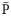
Average positive and negative power about the arms (P¯arm) and legs and trunk (P¯T+L) for the poling (A-D) and swing (E-H) phases in uphill double-poling at increasing external power at shallow (INC5, 5%) and steep (INC12, 12%) inclines. Values are means and 95% CI [N = 14]. # indicates test for interaction; if sig. interaction, p-values are shown for simple main effect for each incline (5% and 12%) while if non-sig. interaction, p-values are shown for main effect of incline (Inc.) and WR (work rate); a,b, and c indicates sig. difference from low, mod, and high work rates at each incline, respectively (p<0.05), if sig. interaction or at pooled inclines if non-sig. interaction; * indicates sig. difference between inclines at the same work rate (p<0.05).